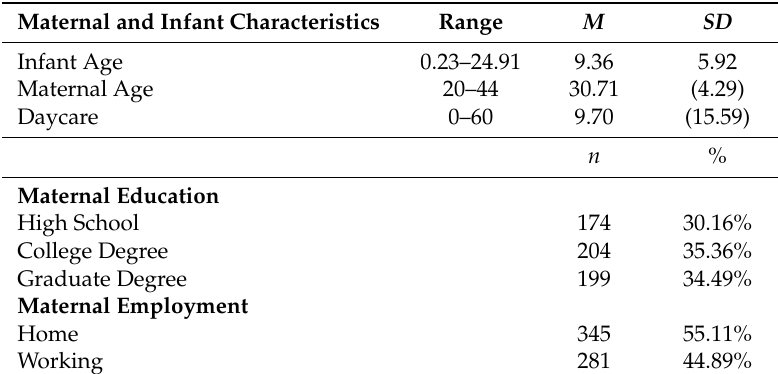
Table 1. Demographic information for the participants in Study